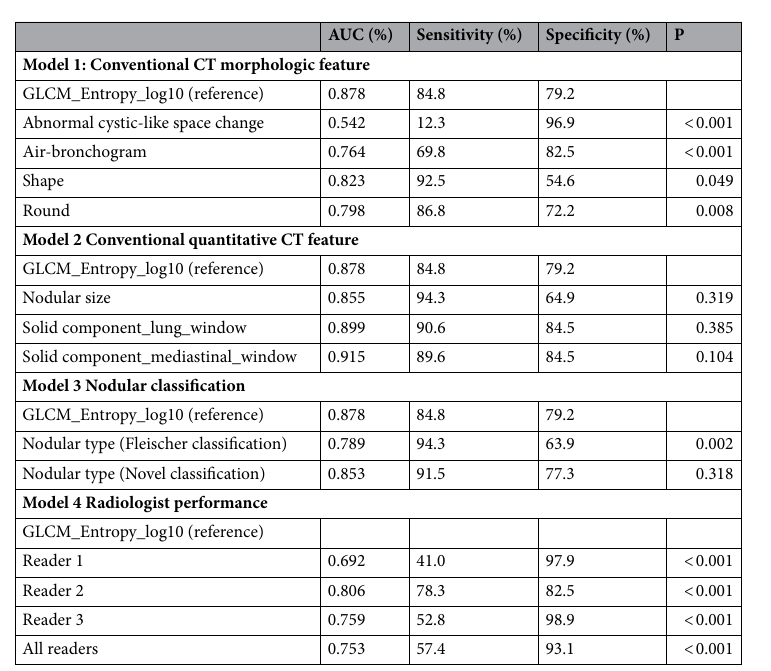
Table 5. Comparison of ROC curves for radiomic feature, conventional CT feature and radiologists in differential diagnosis of invasive lesions versus preinvasive lesions. ROC receiver operating characteristic, AUC area under curve, GLCM gray-level co-occurrence